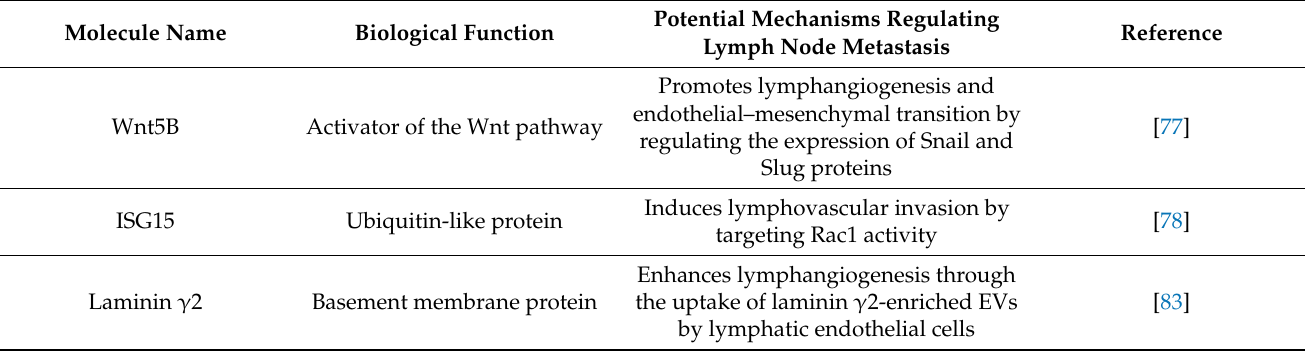
Table 3. Major biomolecules involved in lymph node metastasis in Taiwanese patients with oral squamous cell carcinoma (SCC). Molecule